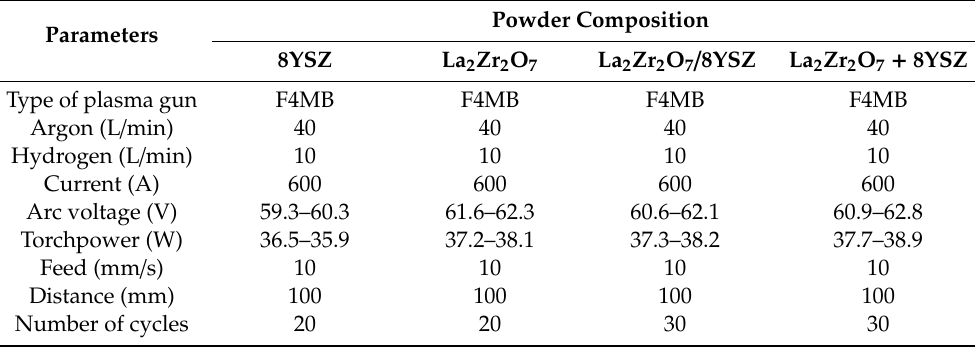
Table 3. Parameters of the atmospheric plasma spraying